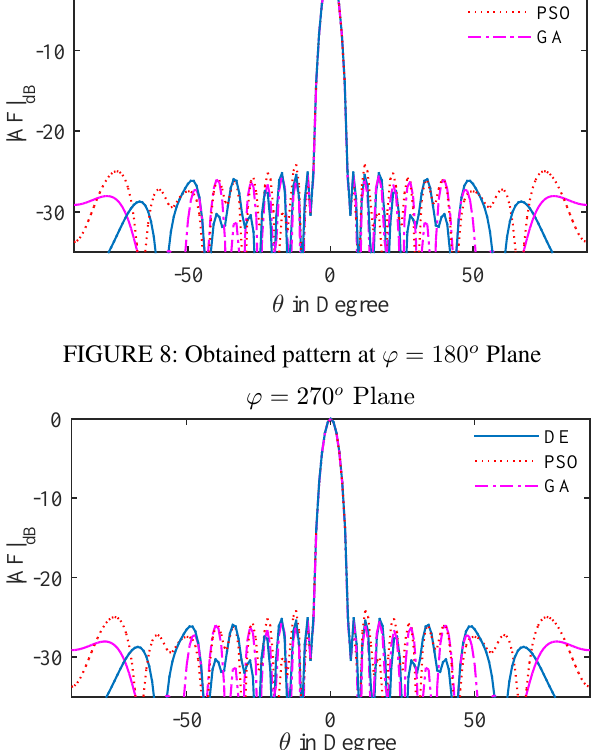
FIGURE 6: Obtained pattern at ϕ = 0 o Plane